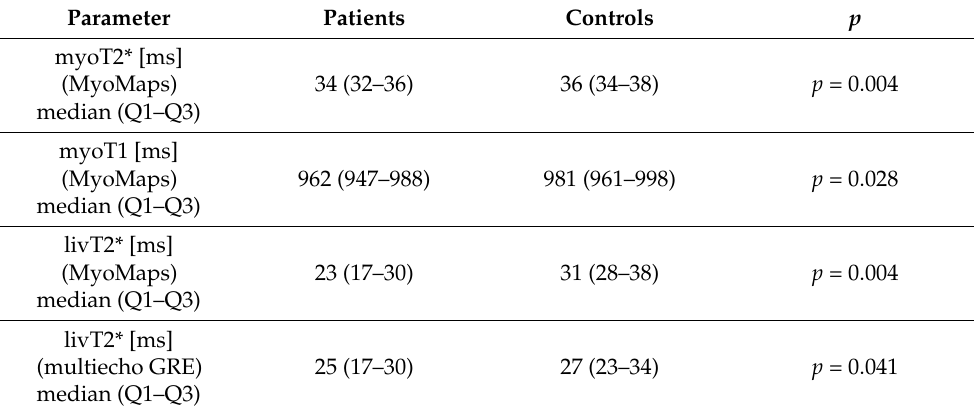
Table 3. Relaxometry parameters in the study group. Data are presented as median (25th–75th